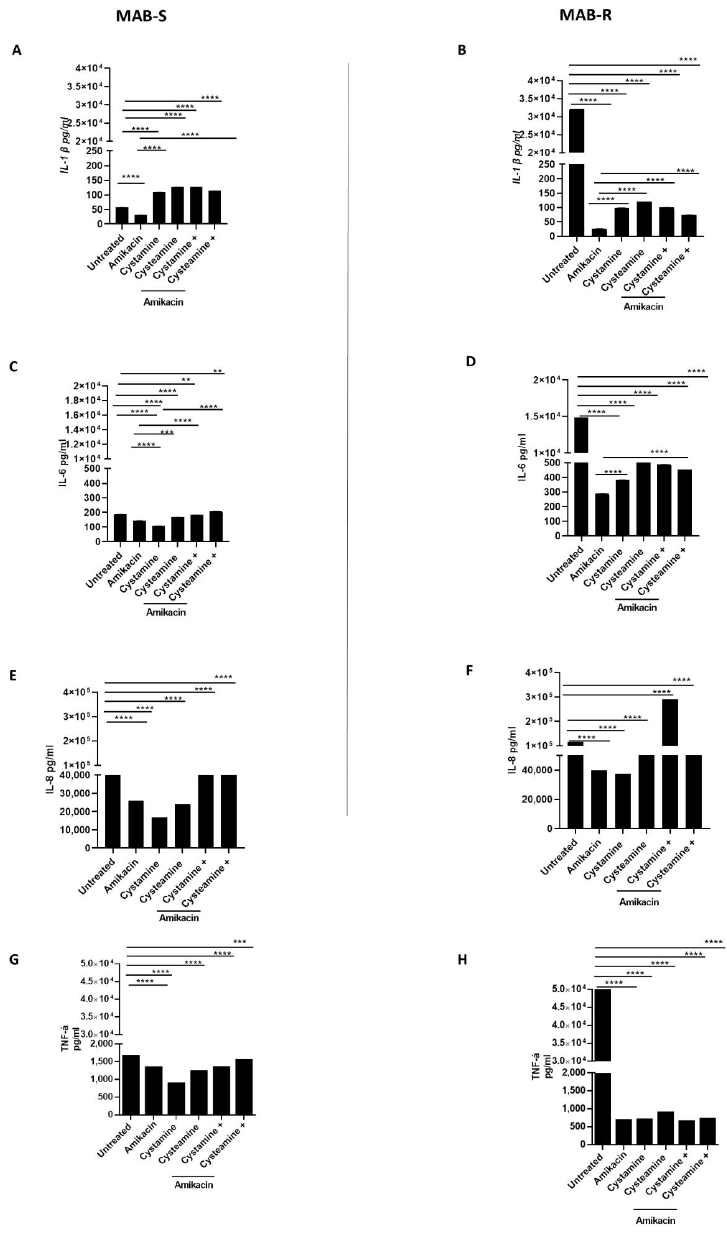
Figure 5. Comparison of pro-inflammatory cytokine production of MAB- R and S variants.